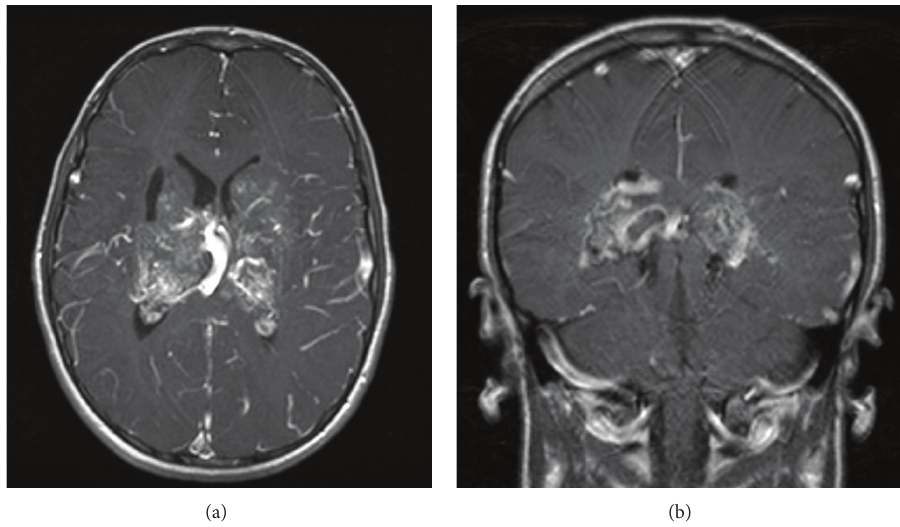
Figure 1: MRI at initial presentation. (a) T1-weighted, axial, gadolinium-enhanced image at the level of the foramen of Monro. (b) T1- weighted, coronal, gadolinium-enhanced image posterior to the third